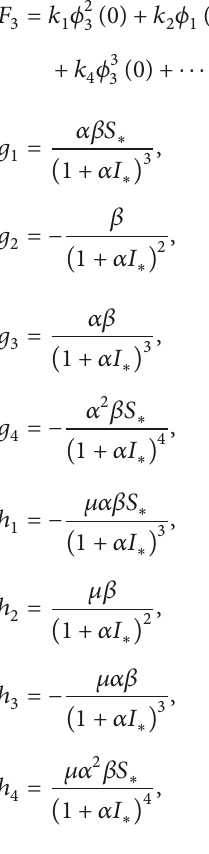
(0) + ℎ 𝜙 2 1 3 (0) + ⋅ ⋅ ⋅ 𝜙 3 + ℎ 4 3